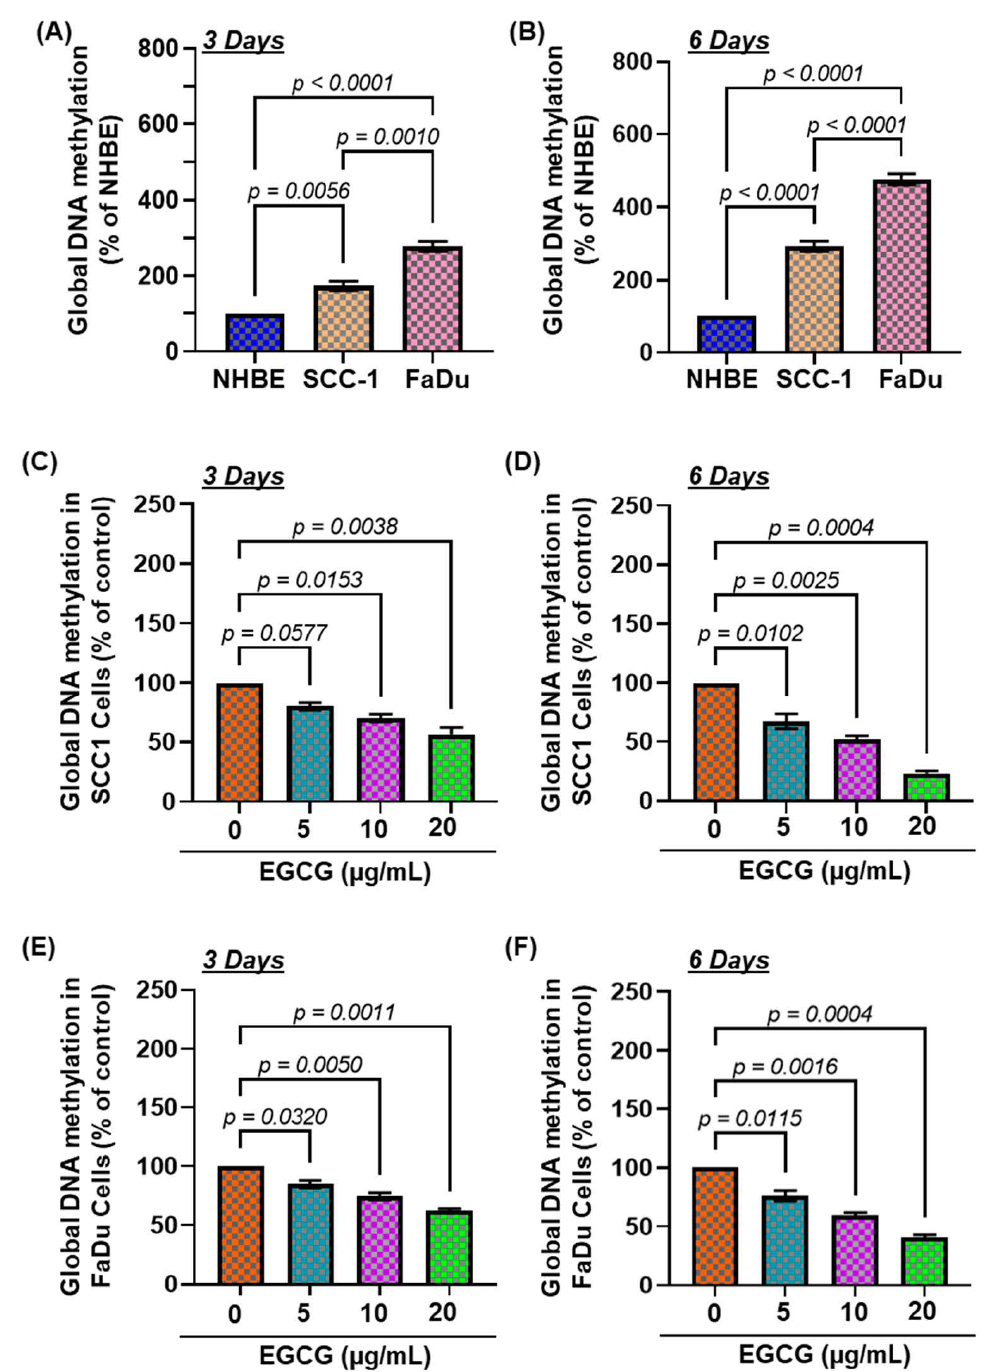
Figure 1. Effect of EGCG on global DNA methylation levels in head and neck squamous cell carcinoma cell lines. Comparative levels of global DNA methylation in NHBE, SCC-1, and FaDu cells. Data are presented in terms of percentage of NHBE, used as normal control cells. Significant difference of global DNA methylation level versus NHBE ( A , B ). Effect of EGCG on the global DNA methylation levels in SCC-1 ( C , D ) and FaDu ( E , F ) cells. Both HNSCC cell lines (SCC-1 and FaDu) were treated with various concentrations of EGCG (0, 5, 10, and 20 µ g/mL) for 3 and 6 days, and the levels of global DNA methylation were determined using a global DNA methylation kit. Data are presented in terms of percentage of control (non-EGCG-treated) group, which was assigned a value of 100%, and as means ± S.E.M. n = 3.